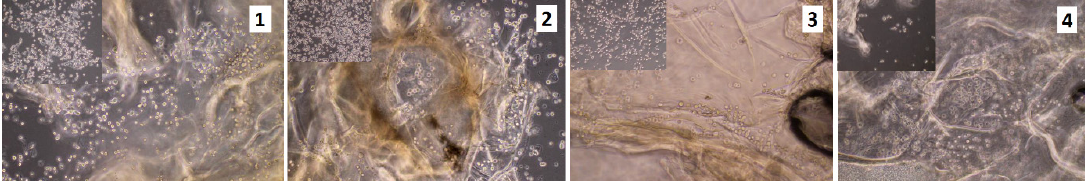
Figure 13. Unsterilized scaffolds coated with fibronectin (100 ng/1 mL), rinsed in antibiotics; 3rd of the cell culture (sample 1—chitosan crosslinked with adipic and malonic acid; sample 2—chitosan crosslinked with adipic and L -glutamic acid; sample 3—chitosan crosslinked with adipic, L -glutamic and malonic acid; sample 4—chitosan crosslinked with adipic and levulinic).